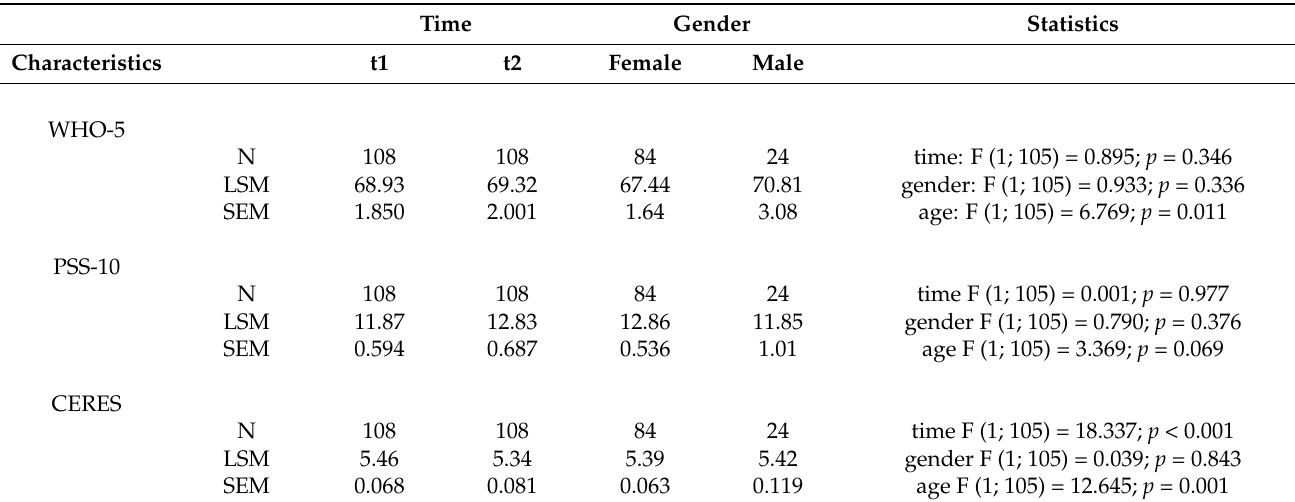
Table 2. Measures of mental well-being (WHO-5), perceived stress (PSS-10), and perceived job- related meaningfulness (CERES) in Austrian telephone emergency counselors in winter 2020/2021 (t1) vs. winter 2021/2022 (t2) and in female vs. male counselors.